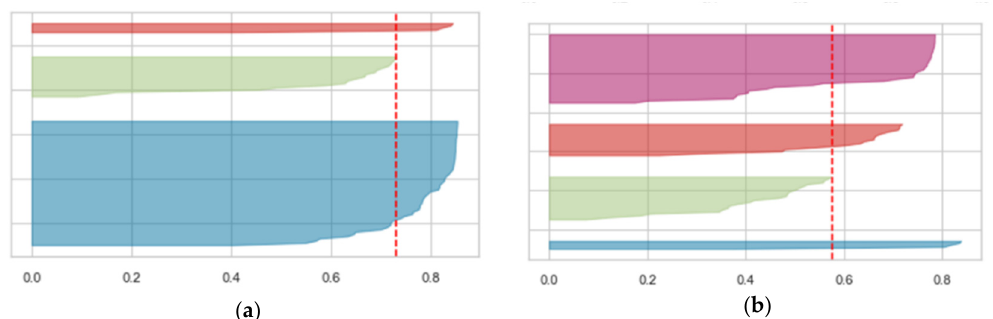
Figure 4. Silhouette scores of K-means algorithm ( a ) three clusters, ( b ) four clusters.